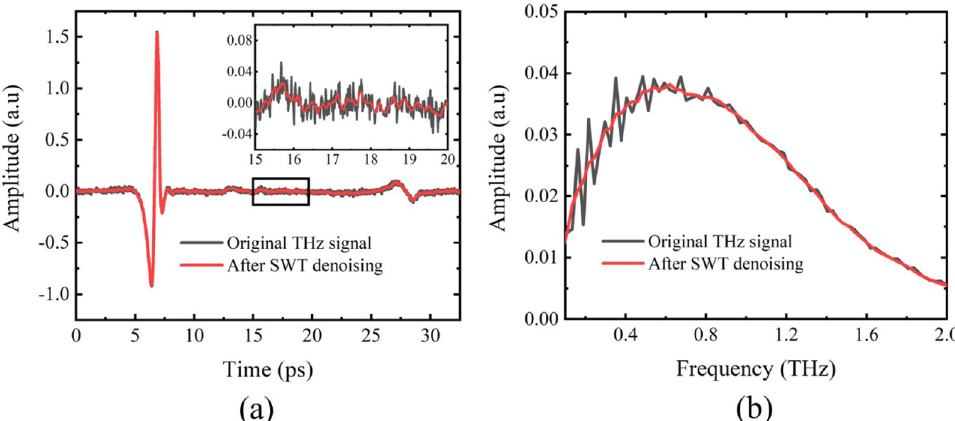
Figure 5 THz sample signal with and without wavelet de-noising in a time domain and b frequency domain. The inset in a shows the fluctuations in the signal due to environmental noise and their removal by the